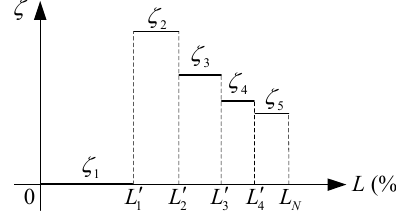
Figure 3. Relation between ζ and loading